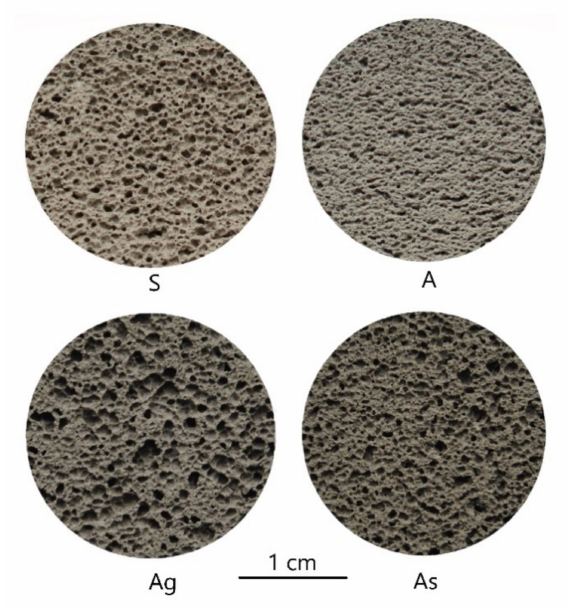
Figure 2. Macrostructure of synthesized geopolymers. Table 4. Characteristics of the synthesized samples.